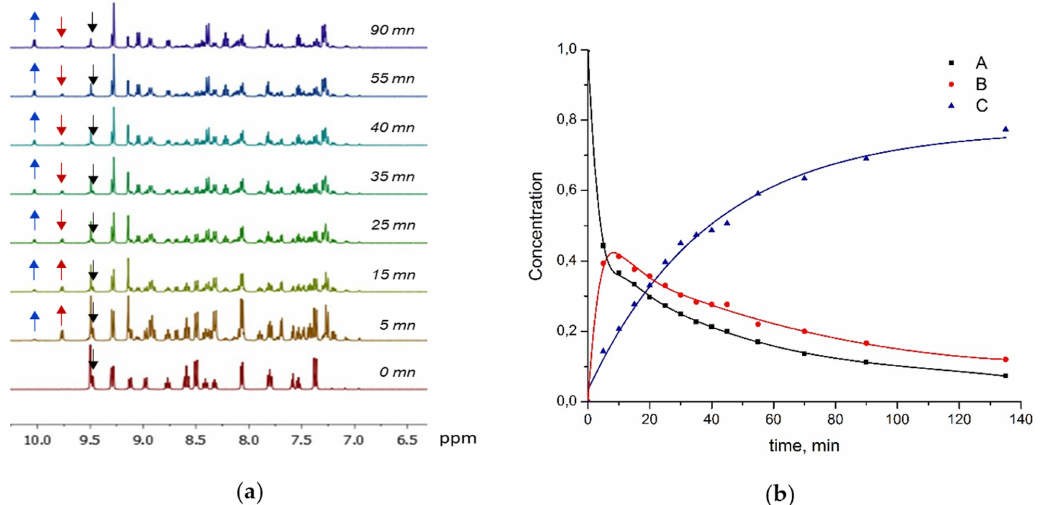
Figure 2. ( a ) 1 H-NMR tracking during the irradiation of [RuT1B0(NO)](PF 6 ) 3 (A) in DMSO- d6 , at λ = 395 nm (black, red, blue arrows for A, B, C respectively). ( b ) Relative concentrations of A, B, and C, from the NMR integrated